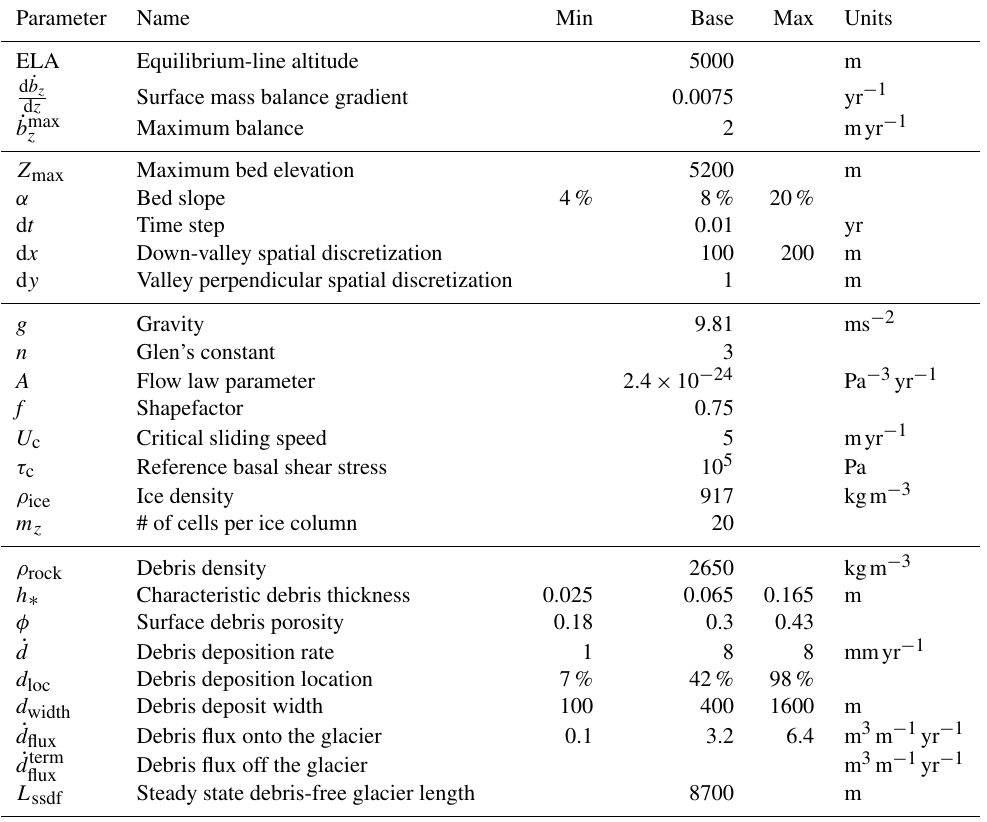
Table 1. Parameter definitions and values.